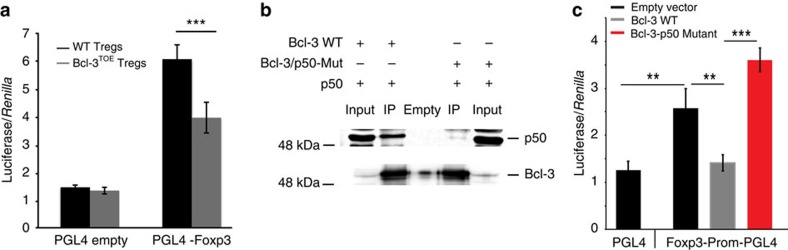
Bcl-3 inhibits Foxp3 promoter activity via direct binding to p50.(a) Reporter assays with constructs containing the endogenous Foxp3 promoter, using in vitro differentiated Tregs restimulated with PMA/Ionomycin from Bcl-3TOE mice. The Luciferase reads from the pGL4 plasmid that contained the Foxp3 promoter or empty were normalized to a Renilla transfection control plasmid. One representative out of two independent experiments with four parallel transfections is shown. Mean±s.e.m. ***P<0.001 using unpaired Student's t-test. (b) Immunoprecipitations using nuclear extracts from HEK293T cells transfected with Bcl-3 wt and Bcl-3 mutant co-transfected with p50 were performed, followed by immune blot analysis using Bcl-3 and p50 antibodies. (c) Reporter assays for Foxp3 gene activity as described in a with in vitro expanded T cells transfected with Bcl-3 wt and Bcl-3-p50 mutant constructs. Normalization was performed as in a. One representative out of two independent experiments with four parallel transfections is shown. Mean±s.e.m. **P<0.01 and ***P<0.001 using unpaired Student's t-test; s>3.